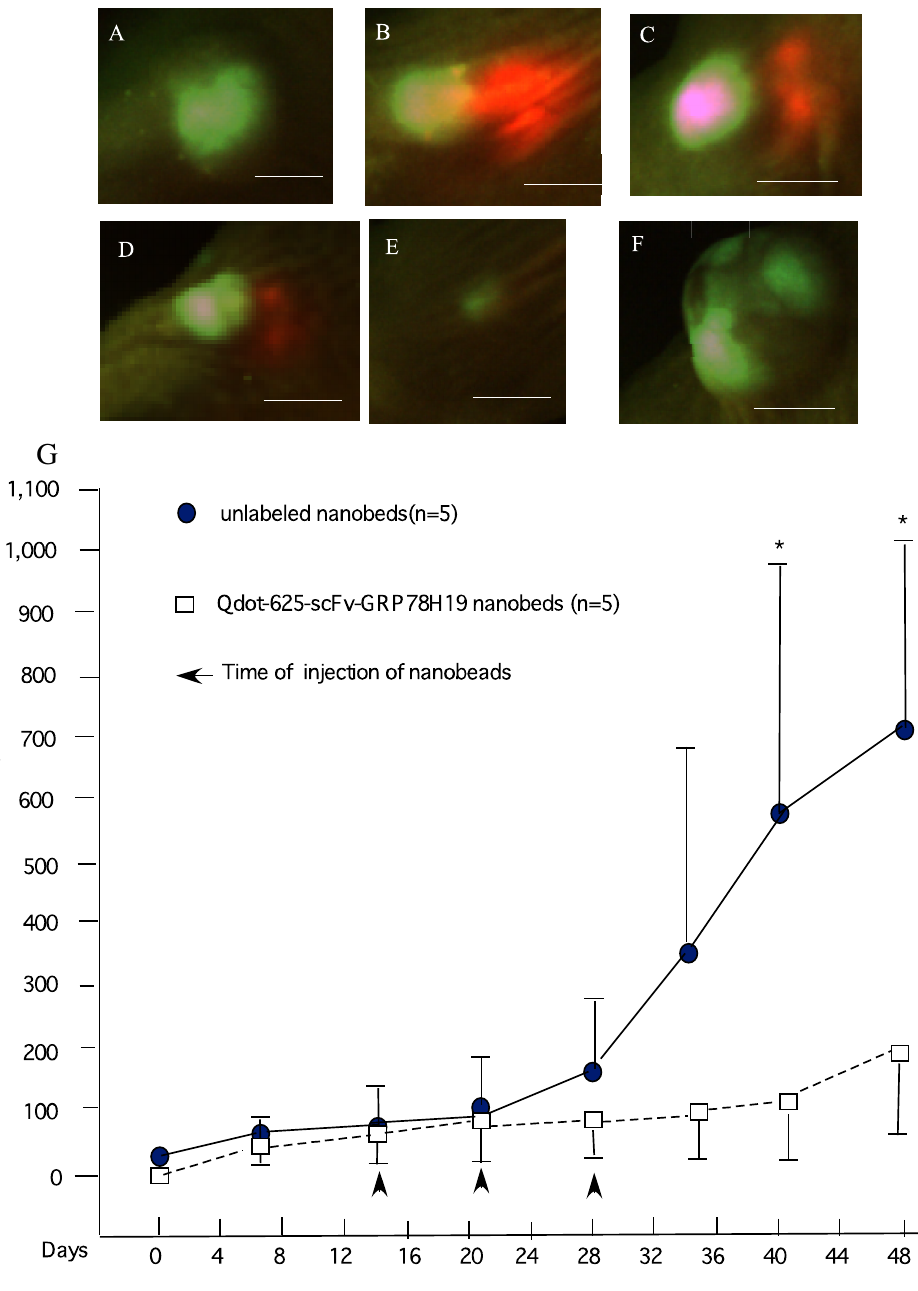
Figure 3. Qdot-GRP78 antibody-conjugates inhibits breast cancer growth. Two-color fluorescence imaging of effect of the injected antibody(red) and GFP tumor(green). ( A ) before injection; ( B ) two days after injection; ( C ) five days after injection; ( D ) two weeks after injection; ( E ) five weeks after injection; ( F ) five weeks after unlabeled nanobeads only injection; ( G ) Total 2 × 10 6 tumor cells were injected subcutaneously into each Balb/c nu/nu mouse. Each experiment used five female mice. In the treatment group, the Qdot-GRP78 antibody was intratumorally injected into pre-established tumors (on the second week) (white square). Then injected at weekly interval for three weeks. In control groups, mice received unlabelled nanobeads alone (black circle. * p < 0.05, two-tailed Student’s t test. Scale bar represents 5